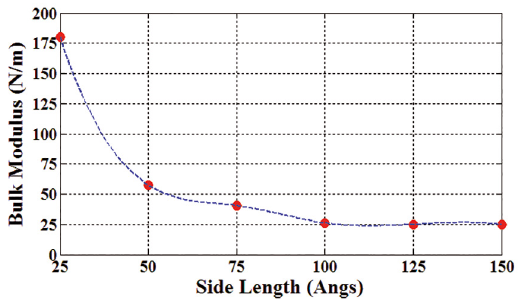
Figure 13: Computed bulk moduli of square graphenylenes with different side lengths